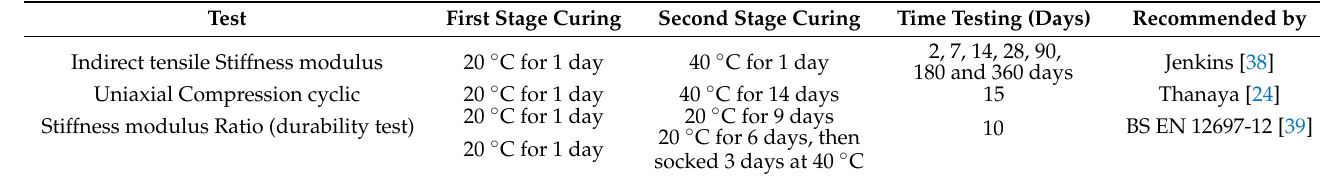
Table 4. CBEMs curing